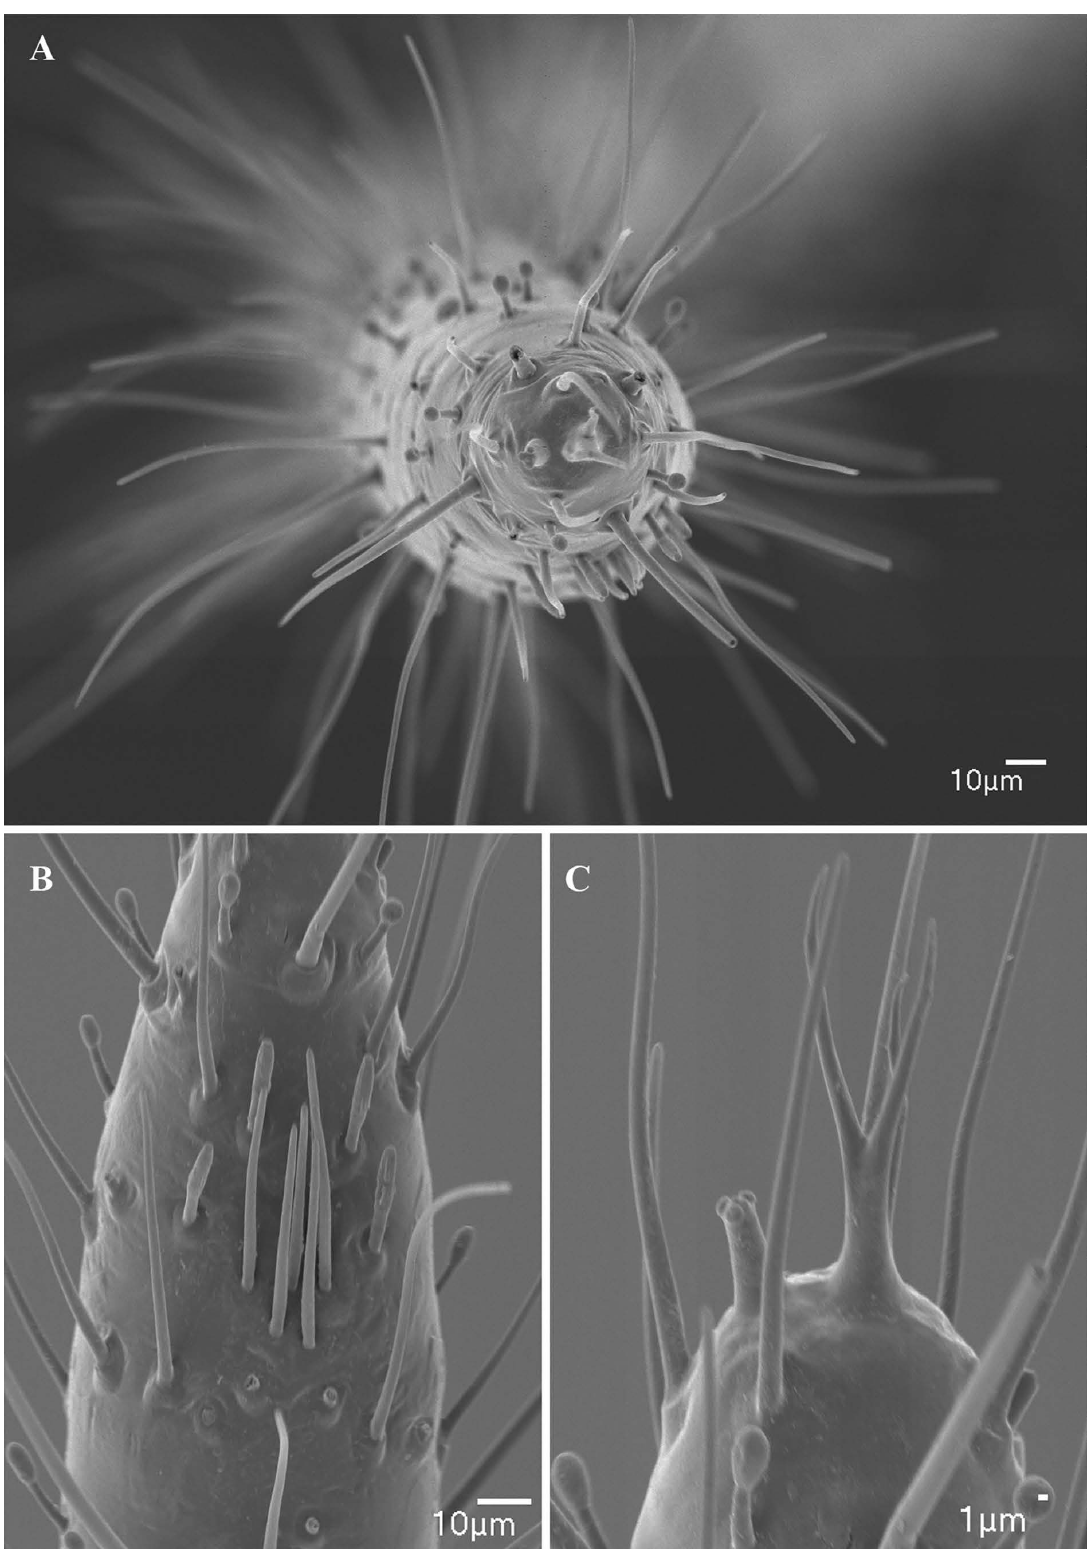
European Journal of Taxonomy 772: 1–409 (2021) Fig. 56. Charinus cearensis sp. nov. (CHNUFPI 1255), antenniform leg I, ♀. A . Apex of distal article. B . Rod sensilla and olfactory setae. C . Apex of distal article of tarsus showing claw and tarsal organ.